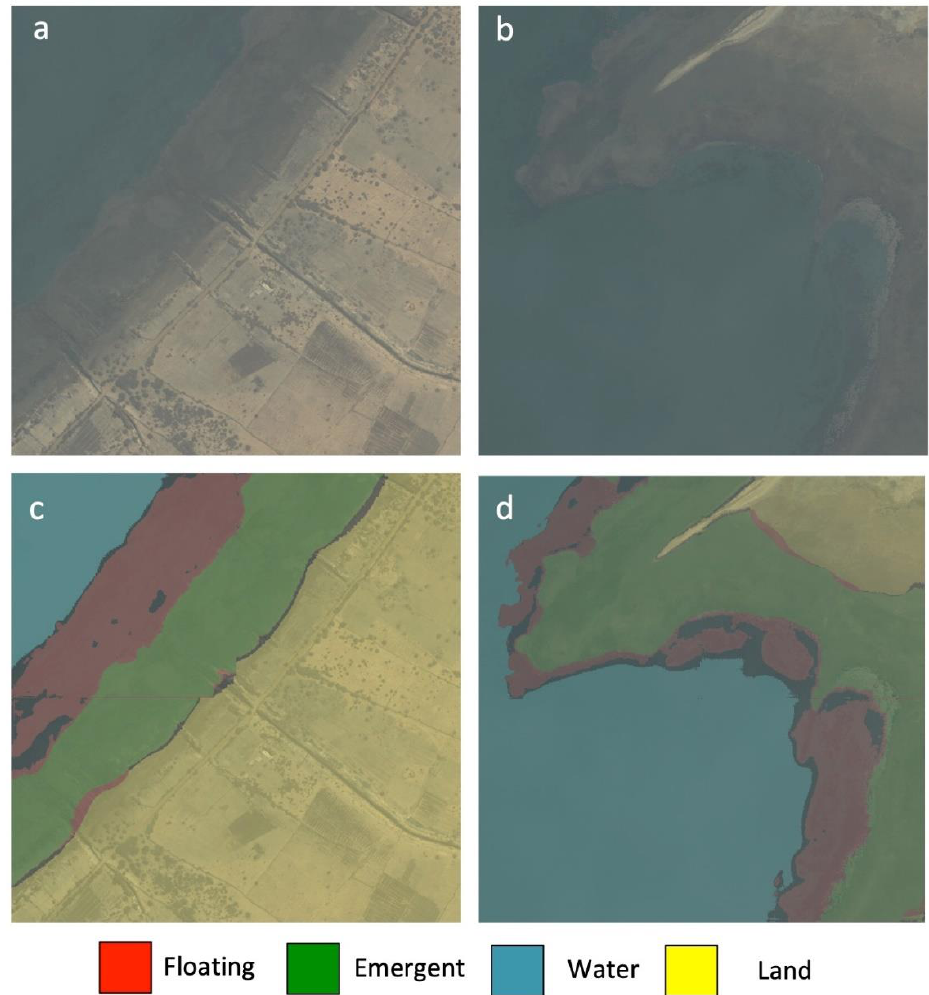
Figure 7. Comparison between satellite images and the corresponding inference maps. ( a , b ) WorldView-2 satellite imagery, ( c , d ) inference map (red: floating; green: emergent; blue: water; yellow: land) produced by the trained U-Net model. The black colored pixels on the inference map refer to the false positive values of floating vegetation.